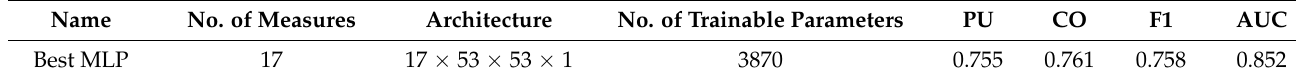
Table 2. Our Best Model. No. of Measures is the number of input measures.